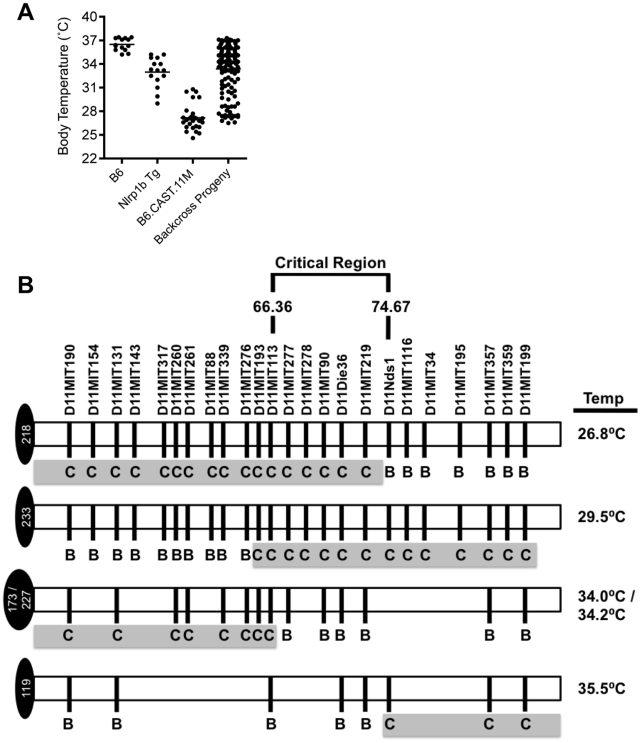
Refining the chromosome 11 critical region bestowing the LT-Induced ERP.
A, Body temperature recordings of backcross progeny (n = 139) as well as B6.CAST.11M (n = 21), B6Nrlp1b
(129S1) (n = 5) and B6 control mice (n = 5) following i.p. injection of 15 µg PA+7.5 µg LF. Mice were monitored as previously described. B, Backcross progeny genotypes at microsatellite markers on chromosome 11 were determined by PCR as described in Methods. Lowest body temperature for each animal following LT challenge was determined as described above.